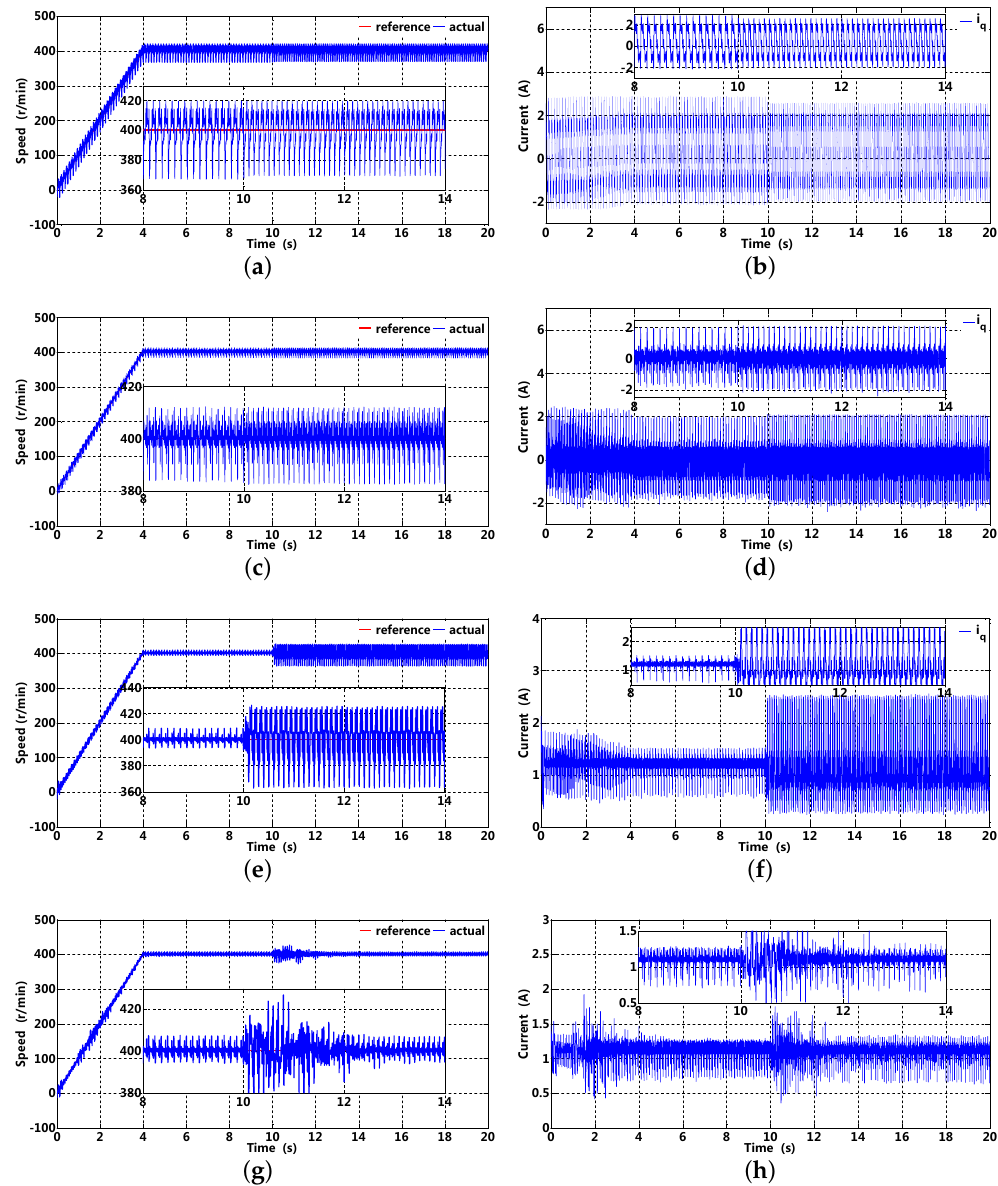
Figure 17. Speed and corresponding q -axis current based on original PI controller (without q -axis current compensation), DOB, RRC, and ARRC. ( a,b ) speed and corresponding q -axis current with an original PI controller; ( c,d ) speed and corresponding q -axis current with DOB; ( e,f ) speed and corresponding q -axis current with RRC; ( g,h ) speed and corresponding q -axis current with ARRC.